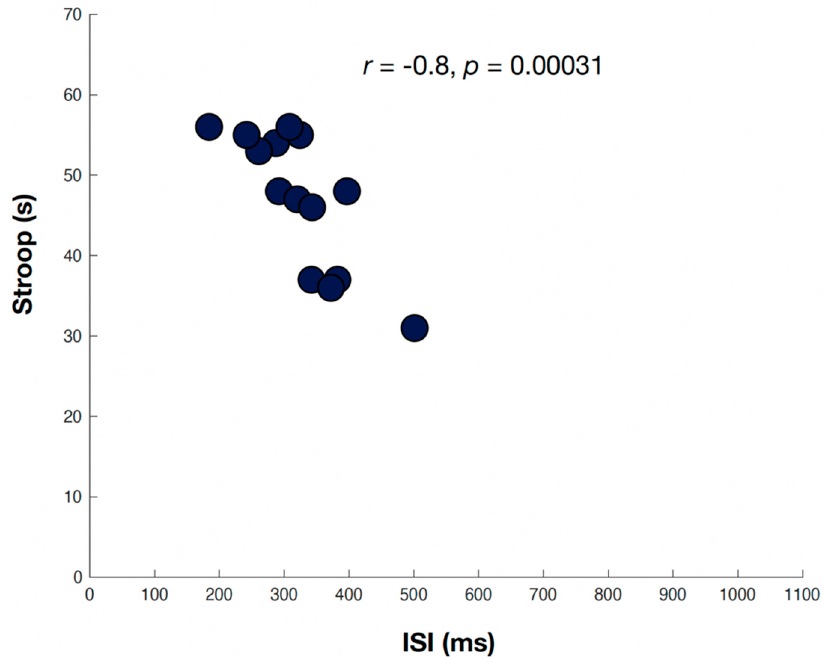
Figure 1. Relation of inter-saccadic intervals (msec) and the Trails Making Test Part A (T-score), a marker of atten- tion/working memory. Two participants (grey circles) were excluded due to poor eye-tracking data quality.